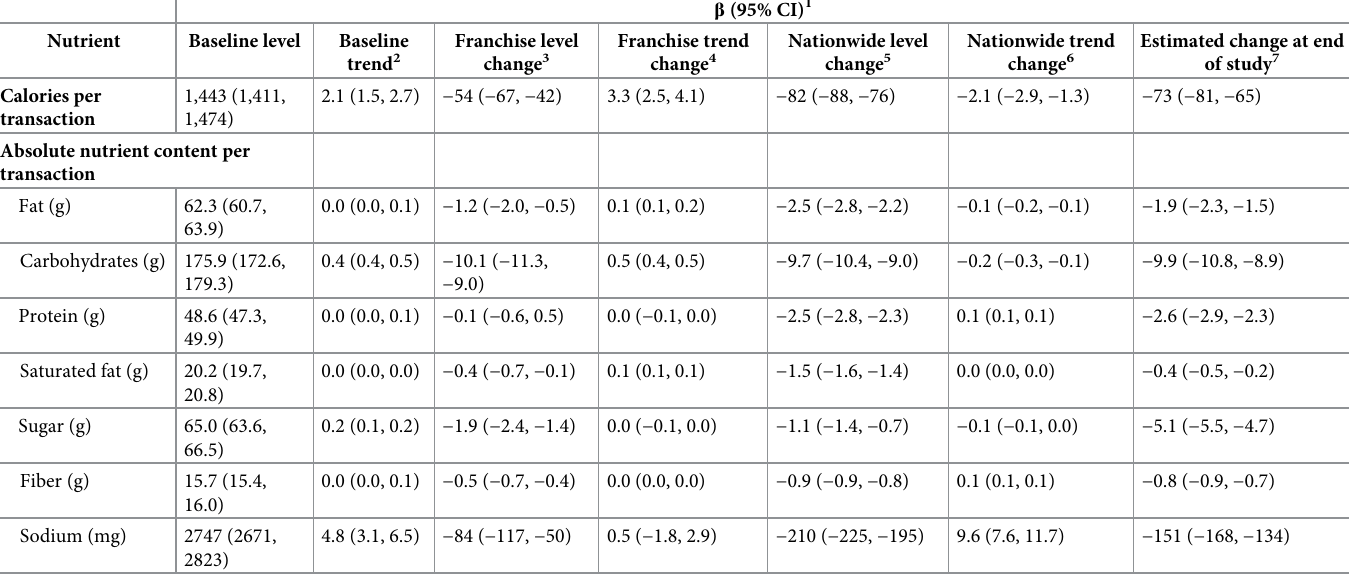
Table 2. Interrupted time series for change in mean calories and mean nutrients purchased per transaction after franchise calorie labeling implementation (April 2017) and after nationwide calorie labeling implementation (May